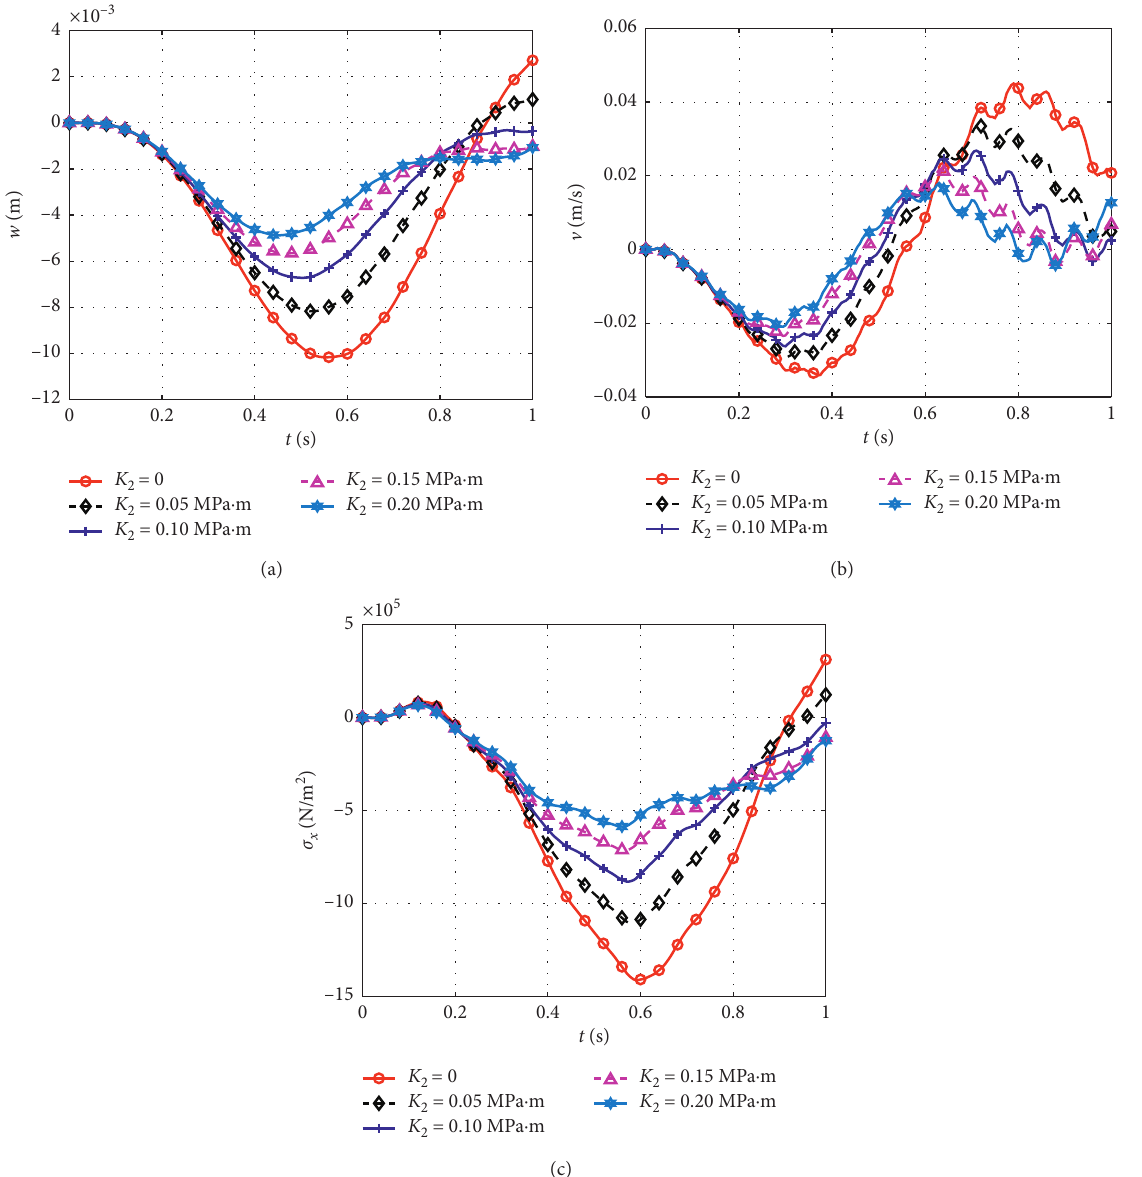
Figure 11: Effect of the Pasternak foundation K · m) on the dynamic response of the sandwich plates with negative Poisson’s ratio. (a) 2 (Mpa Deflection w versus time, (b) velocity v versus time, and (c) stress σ x versus time. Table 9: Maximum deflections, velocities, and stress of the plate central point. Maximum